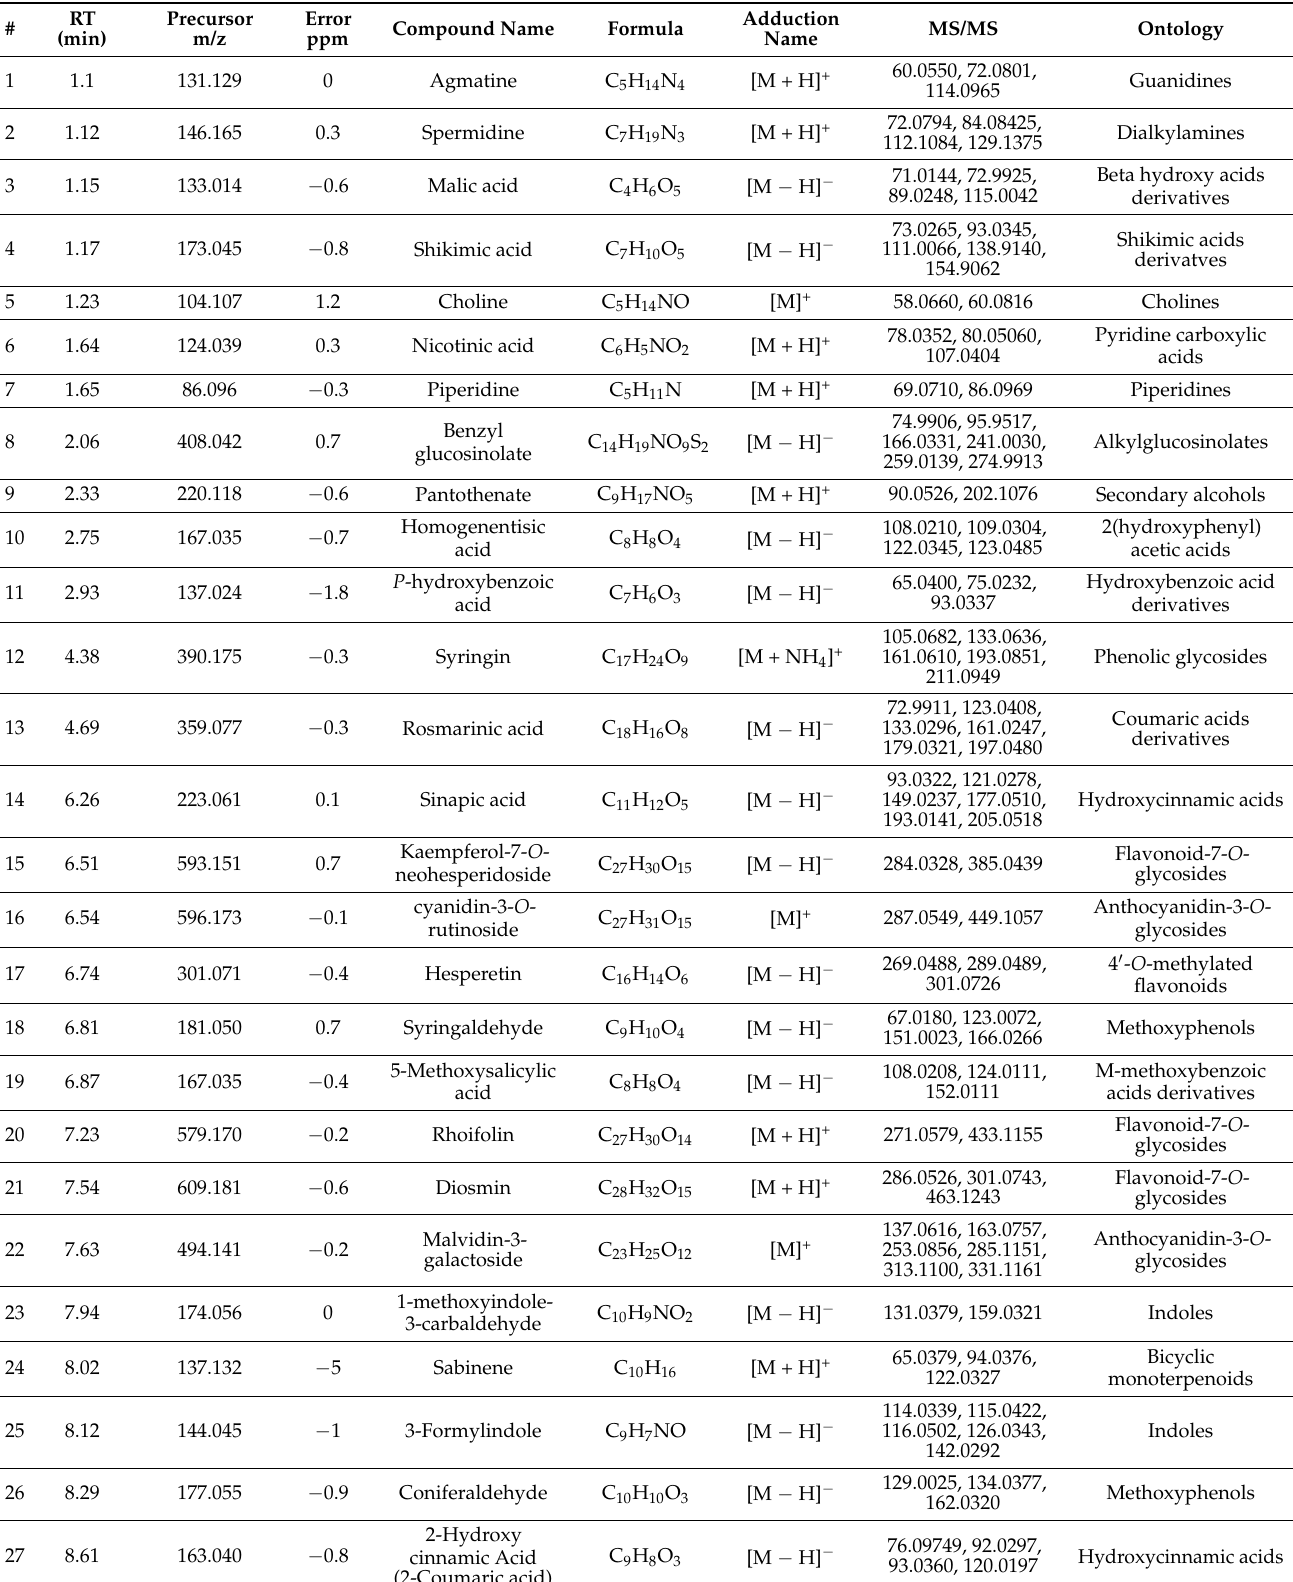
Table 1. LC-ESI-MS/MS analysis of the methanol extract of Salvadora persica stem bark displaying the tentatively recognized